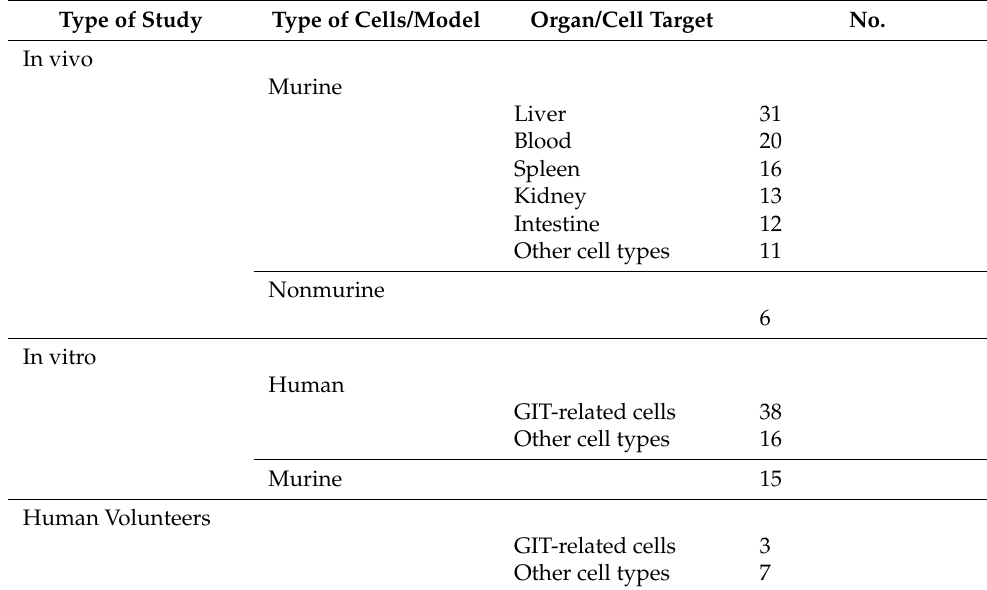
Table 2. Type of studies, models used, and targets of the selected 185 papers.